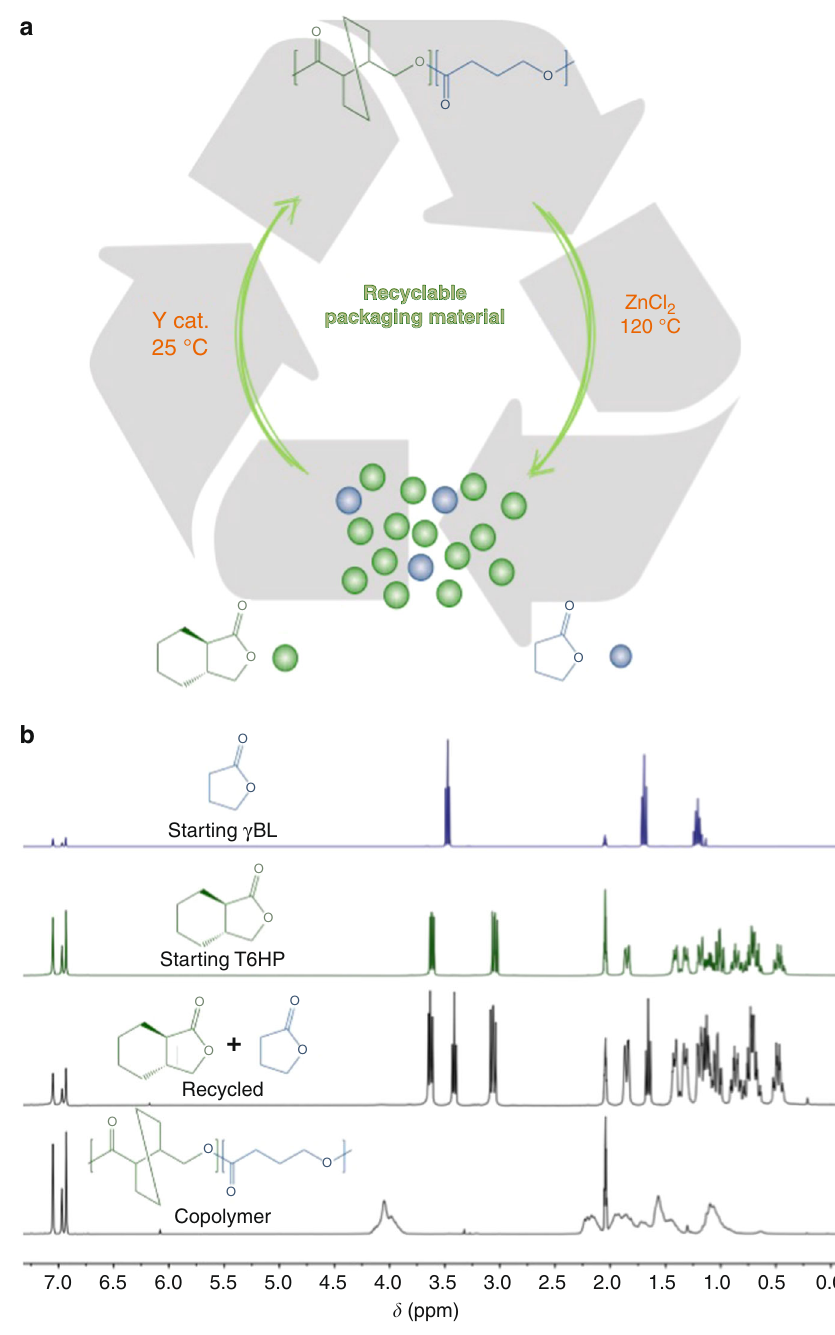
Fig. 3 Chemical recyclability of copolymers. a Closed loop of chemically recyclable polymers. b 1 H NMR spectra (C 7 D 8 ) of starting γ BL (top) and T6HP (second from top) comonomers as comparison, a mixture of the recycled comonomers after depolymerization (third from top), and the copolymer (27% γ BL incorporation) before chemolysis